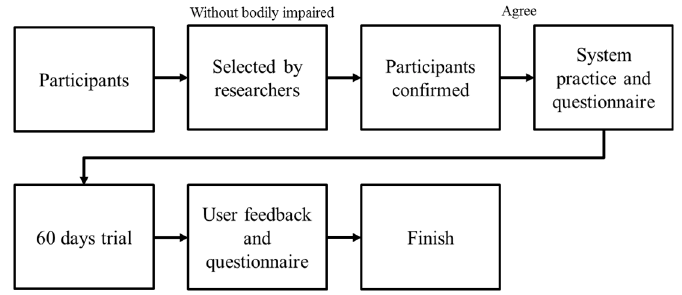
Figure 4. Flowchart of a real-world trial.